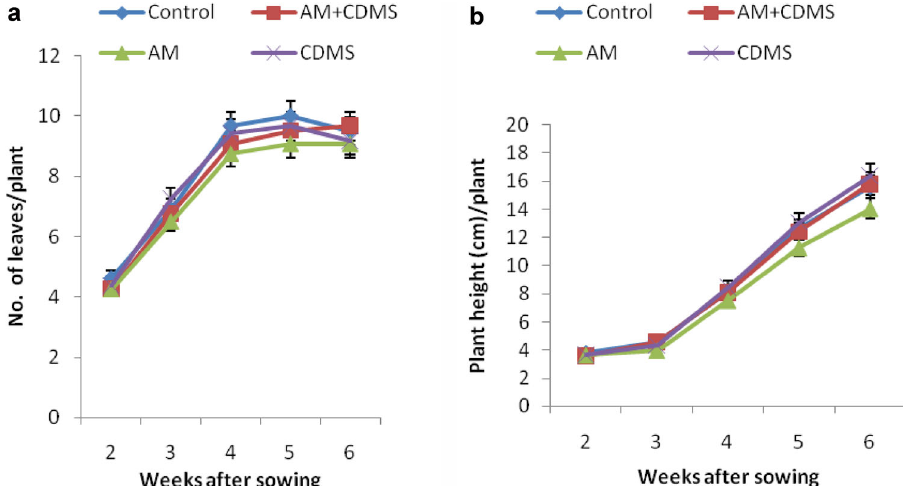
Fig. 1 a Influence of various soil amendments on number of leaves of A.